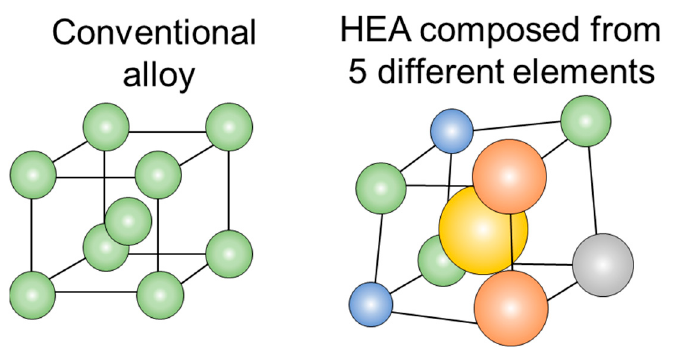
Figure 1. Crystal structure of a conventional alloy vs. high entropy alloys (HEAs).